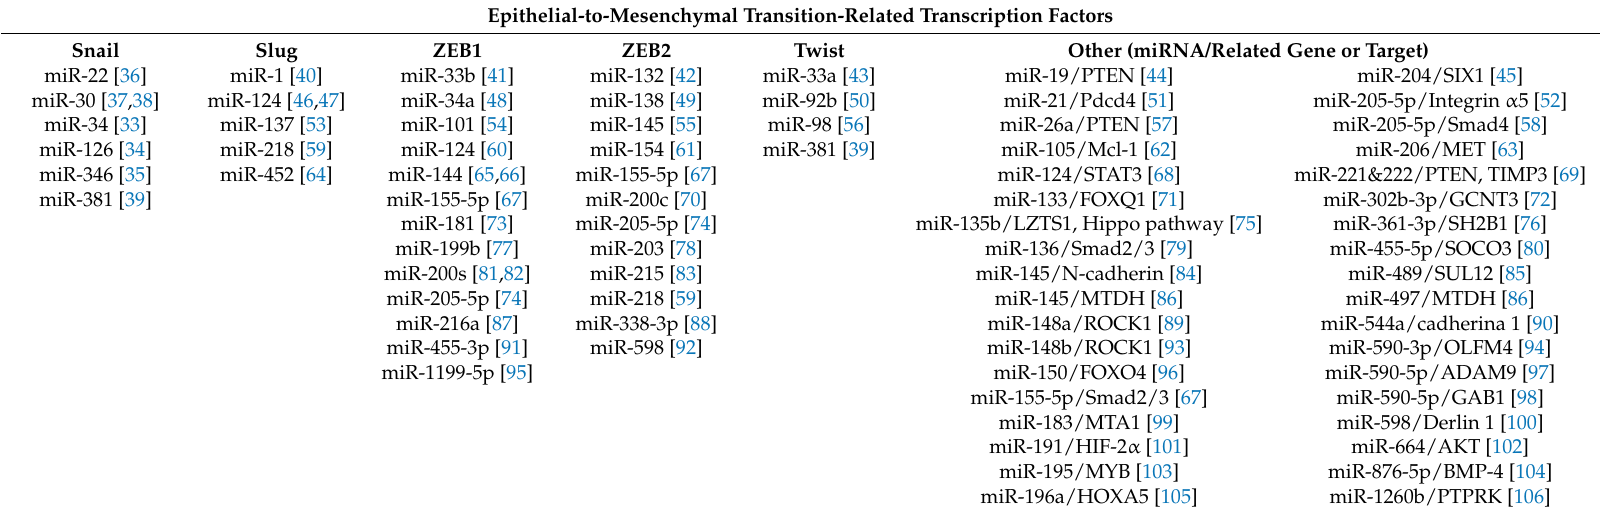
Table 1. Epithelial-to-mesenchymal transition-related transcription factors and associated microRNAs in Non-Small Cell Lung Cancer